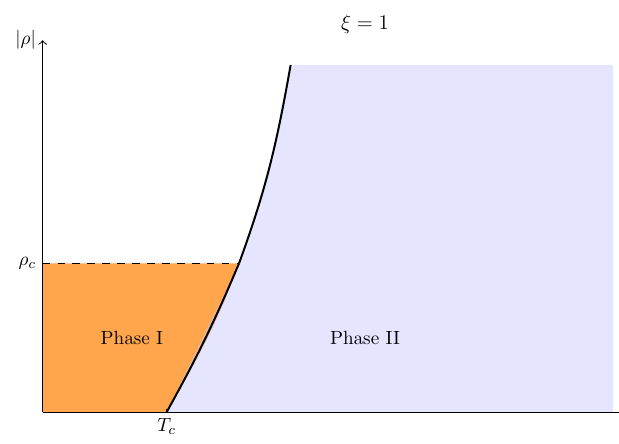
Figure 7 . Phase diagram for the electric solutions of Theory II with (cid:24) = 1 as a function of charge density (cid:26) and temperature T . Below a critical charge density (cid:26) c and a critical temperature T c there is only one, dynamically unstable, black hole solution. This solution exists for arbitrary temperature, but it disappears above (cid:26) c . Above the critical temperature T c there are either two or three solutions depending on whether j (cid:26) j > (cid:26) c or j (cid:26) j < (cid:26) c respectively. The two solutions that exist only above T c are both dynamically stable and the one with larger radius is thermodynamically preferred. At the critical temperature T c , therefore, there is a phase transition from a dynamically stable black hole with negative scalar vev above T c , to a dynamically unstable solution with positive scalar vev . At non-zero charge density the Helmholtz free energy jumps at T c and so this is a zeroth order transition. At zero charge density the free energy is continuous across T c , as is its (cid:12)rst derivative, and so the phase transition becomes second order at (cid:26) =